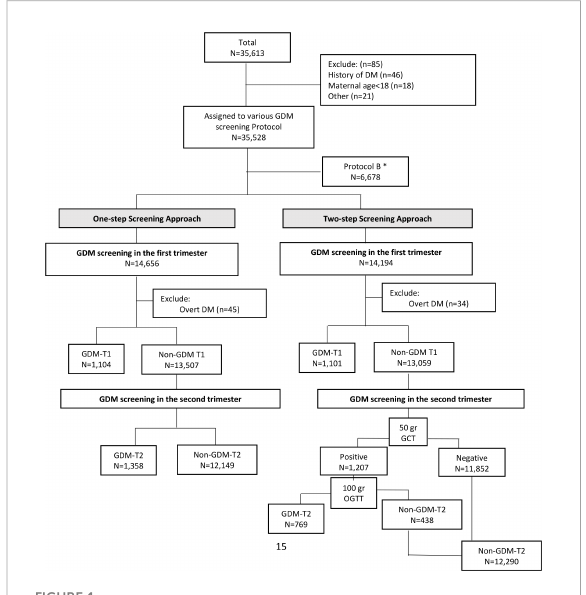
FIGURE 1 Flowchart of the study. *We excluded protocol B since it was not exact comparable with other standard approaches. In this protocol, GDM was de fi ned as two or more of the given plasma glucose values are met or exceeded in One-step with 2-h 75 g oral glucose tolerance test. GDM: gestational Diabetes Mellitus; T1: fi rst trimester of pregnancy; T2: second trimester of